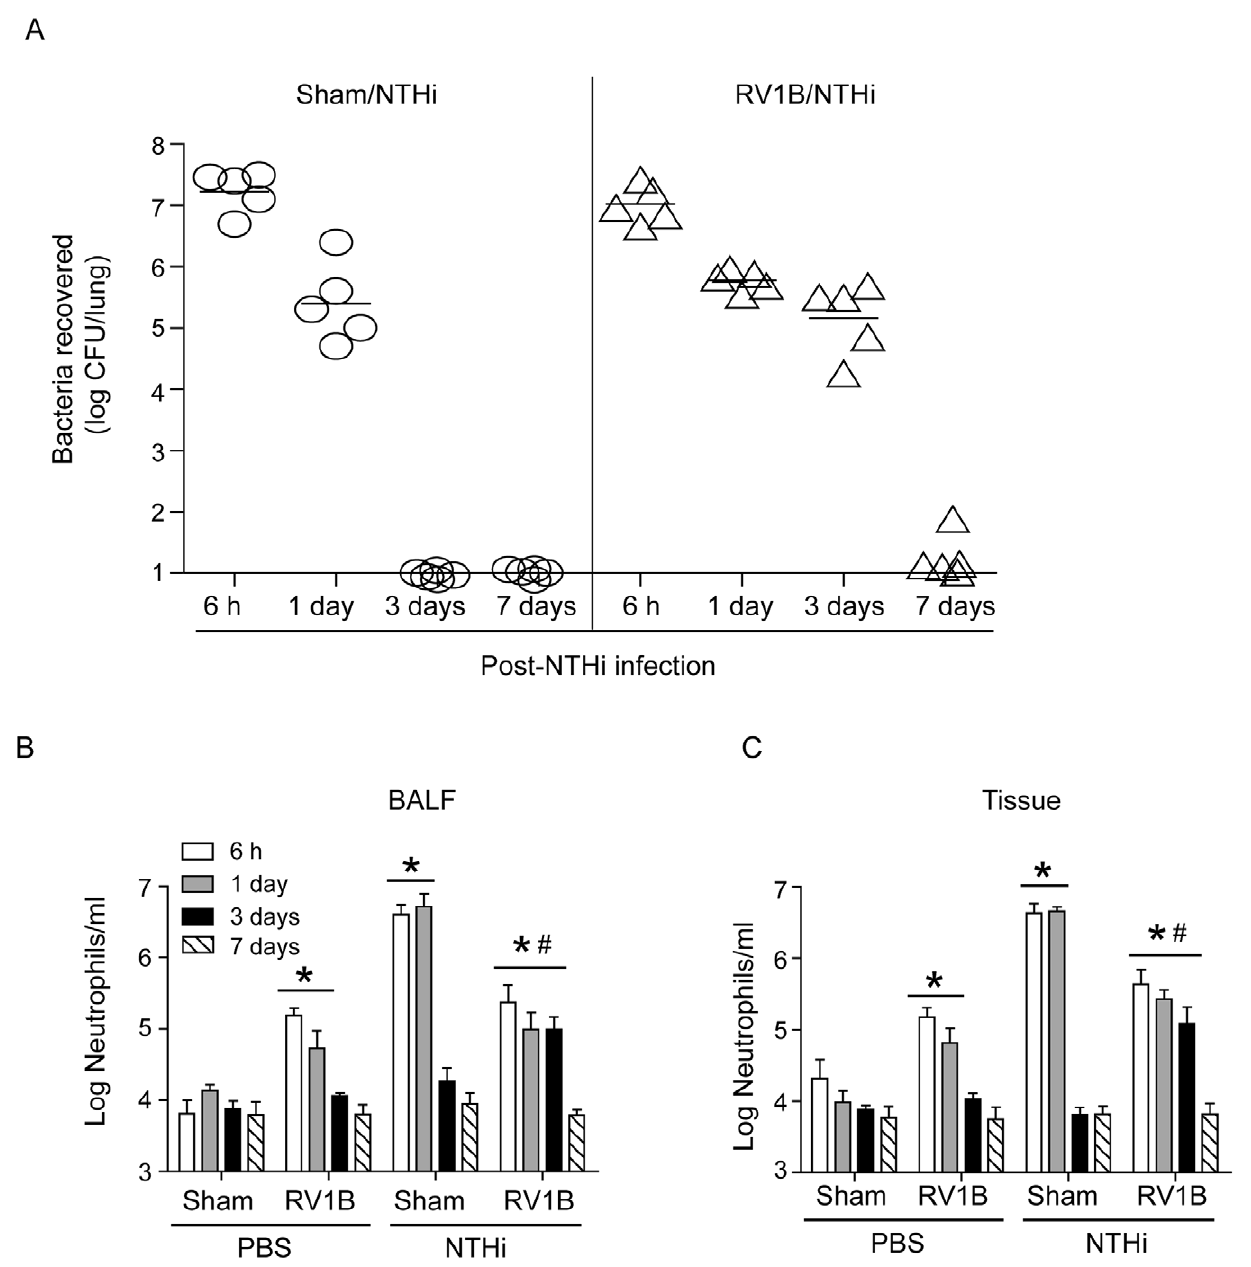
Figure 1. RV infection promotes bacterial persistence and decreases neutrophil infiltration to subsequent bacterial challenge in vivo . BALB/C mice were infected with RV1B or sham by intranasal route. Two days later, mice were infected with NTHi or treated with PBS via intratracheal route and sacrificed at 6 h, 1 day, 3 days or 7 days post-NTHi infection. (A) Mice were sacrificed and lungs collected aseptically, homogenized in sterile PBS and 10 fold serial dilutions of lung homogenates were plated to determine bacterial density. (B) Cytospins of BAL cells and (C) lung digests enriched for leukocytes were prepared, stained with Diffquick and number of neutrophils were counted. Data in A represent mean and range and in B and C, mean 6 SD (n=4–9, * p # 0.05, two-way ANOVA, different from sham; # p # 0.05, two-way ANOVA, different from sham/NTHi infected animals).